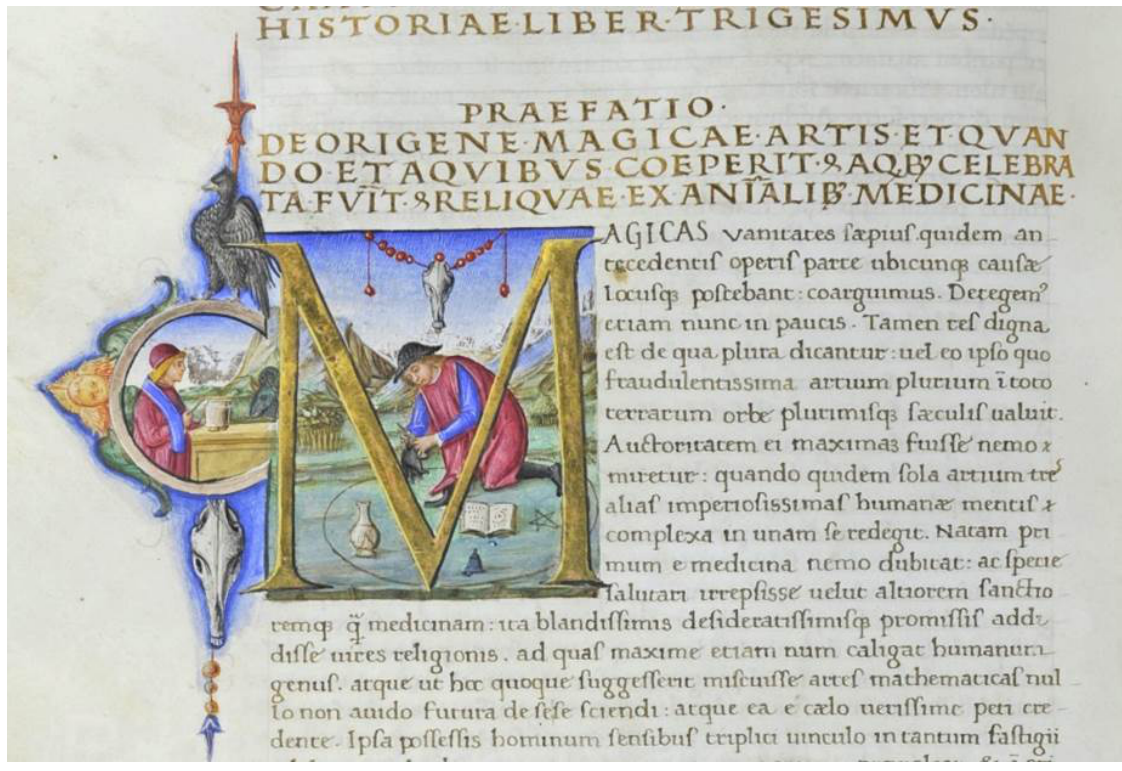
Figure 1 Venice, Biblioteca Nazionale Marciana, MS lat. VI. 245 (coll. 2976), illuminated initial accompanying Pliny’s Natural History book